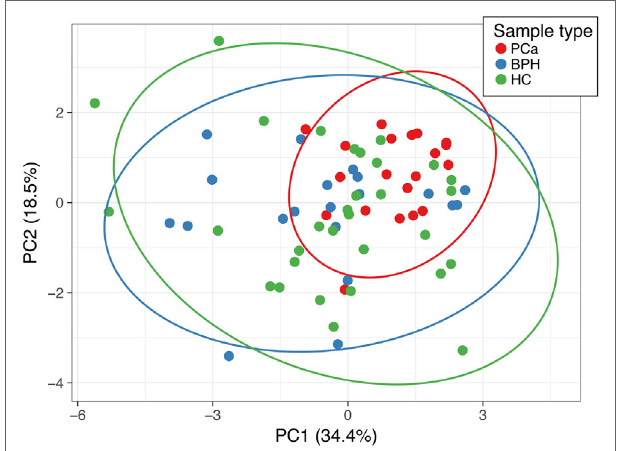
FigUre 3 | Principal component analysis (PCA) of the absolute (normalized) concentrations of all the steroids. Points labeled in red are PCa patients, in blue are the benign prostate hypertrophy patients, green are the healthy controls. Principal component (PC) 1 and PC 2 explain 34.4 and 18.5% of the total variance, respectively. The prediction ellipses are such that with a probability 0.95, a new observation from the same group will fall inside the